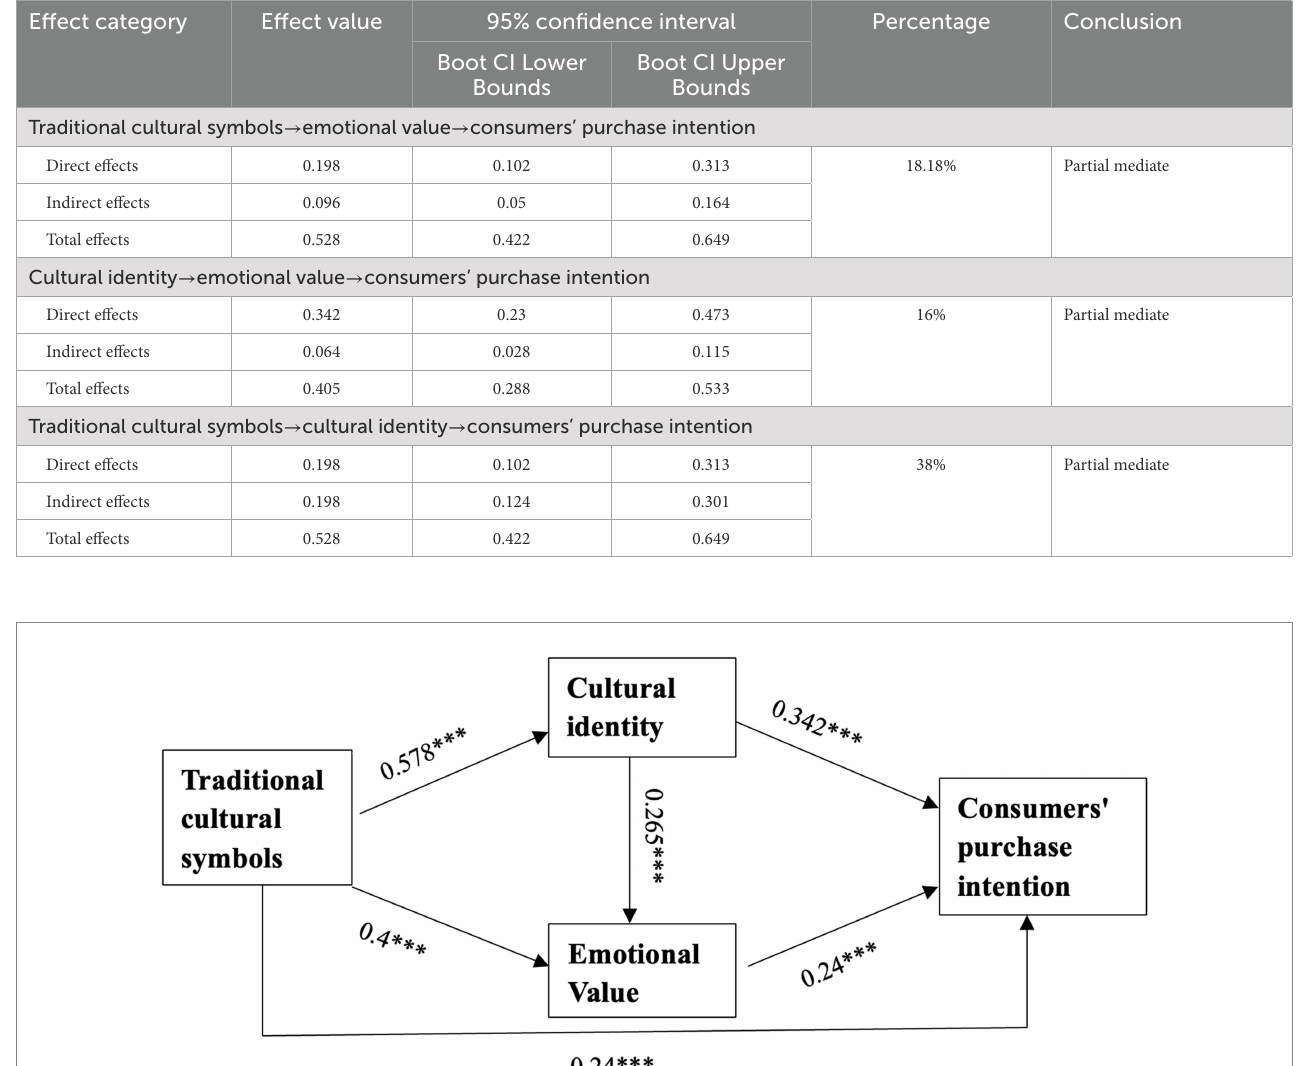
FIGURE 3 The mechanism of traditional culture on purchase responses.